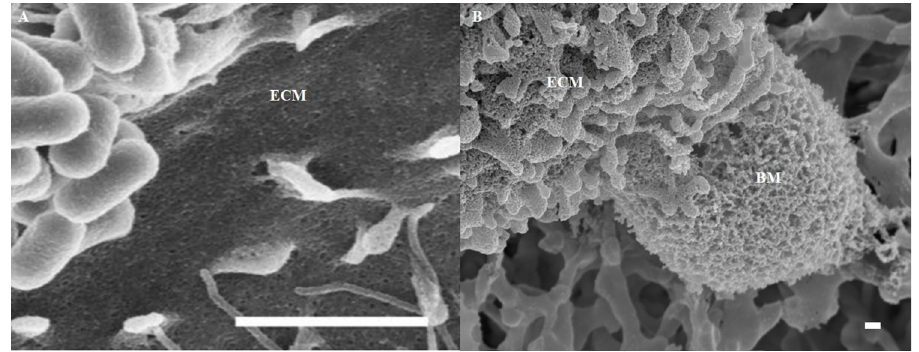
Fig 1. Scanning electron micrographs displaying the apical surface of a polarized epithelial cell interacting with Escherichia coli bacteria, grown on gold mesh grids, dried and coated with carbon, scale bar = 2000 nm [3]. ECM denotes the epithelial cell membrane ( A ); A polarized brain endothelial cell (bEnd5), grown in our laboratory, on an insert membrane, dried and coated with Au:Pd, scale bar = 2000 nm. ECM denotes the endothelial cell membrane and the basement membrane of the BEC is denoted as BM ( B ).